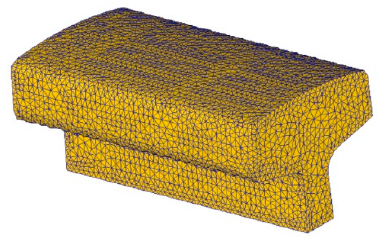
Figure 8. Upper segment of railway rail.